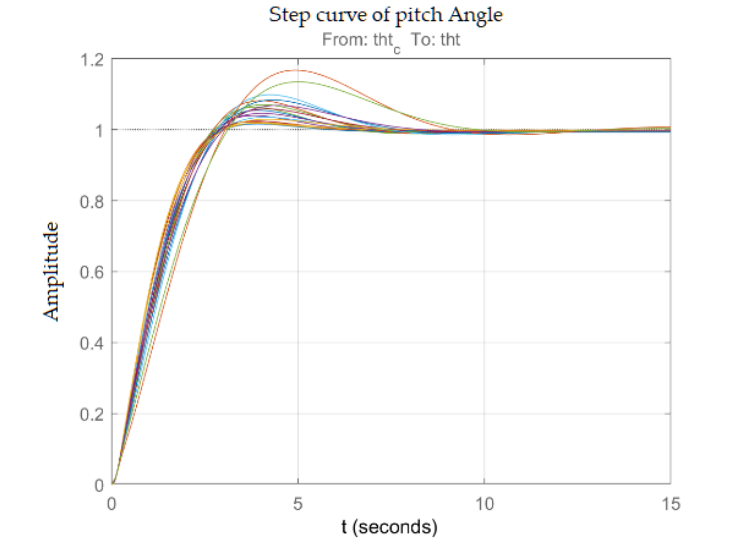
Figure 17. Step response of pitch